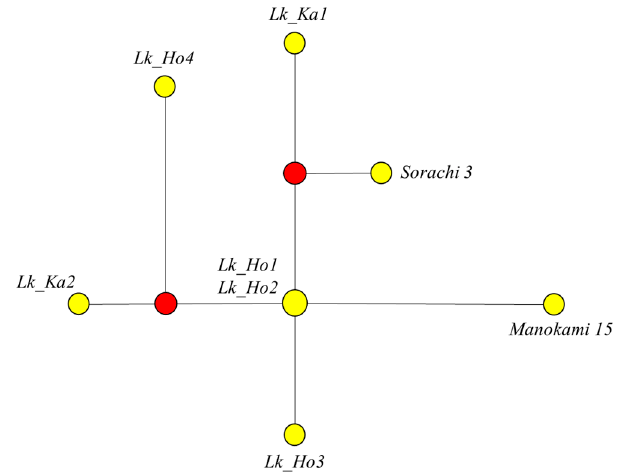
Figure 2. Haplotype network based on SNP sites within eight individuals of Japanese larch. The red dot represents missing haplotypes.